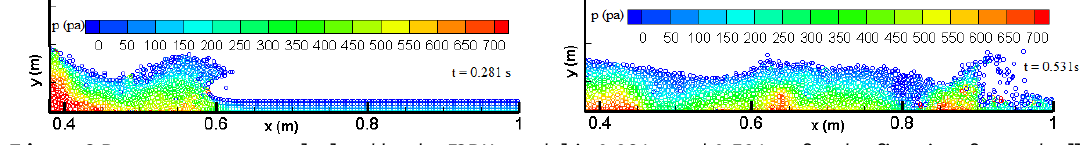
Figure 8 Pressure contours calculated by the ISPH model in 0.281 s and 0.531 s after the first time for gradually collapse of the water column test case